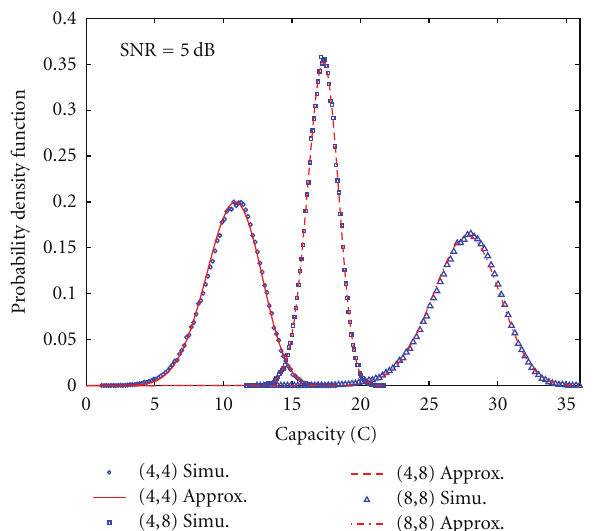
Figure 5: Comparison between simulation and calculation results for distributions of capacities of GMD-based transceivers in (4,4), (4,8), and (8,8) MIMO Rayleigh fading channels. Assuming γ =